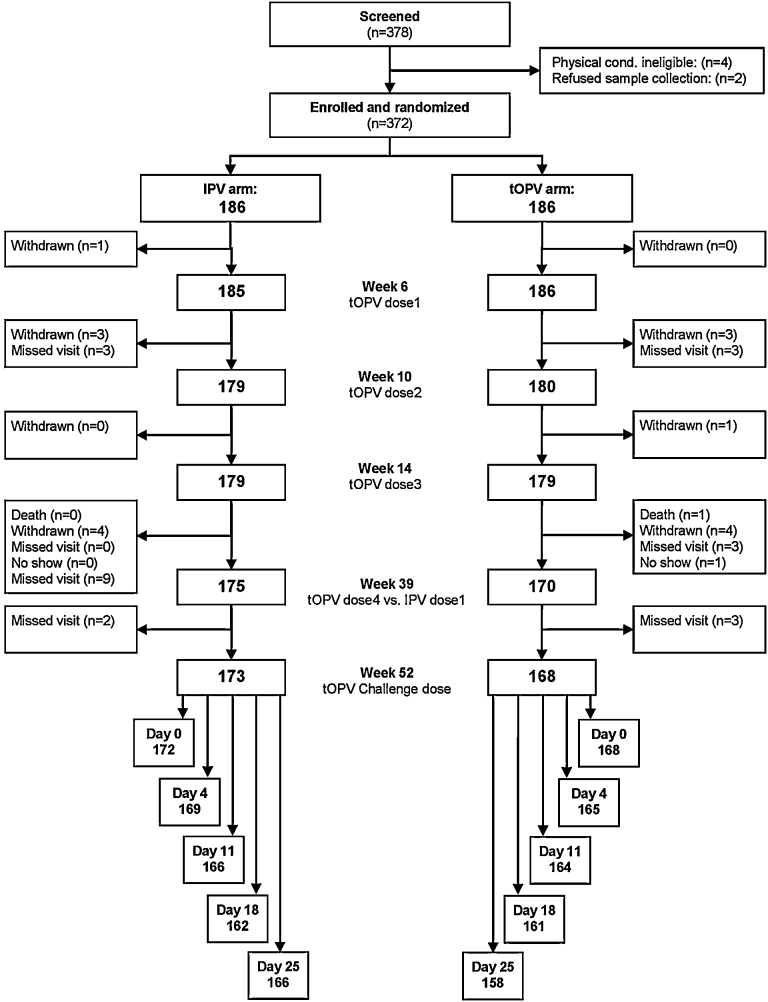
Consort Diagram for the PROVIDE study, Kolkata, India.